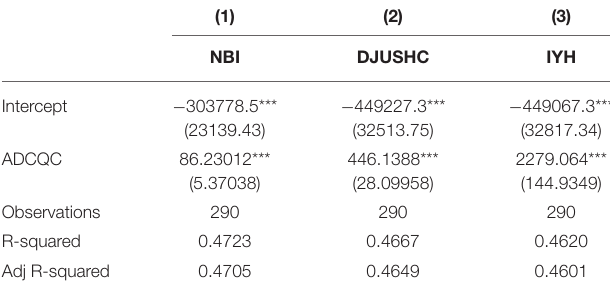
TABLE 8 | OLS regression analysis